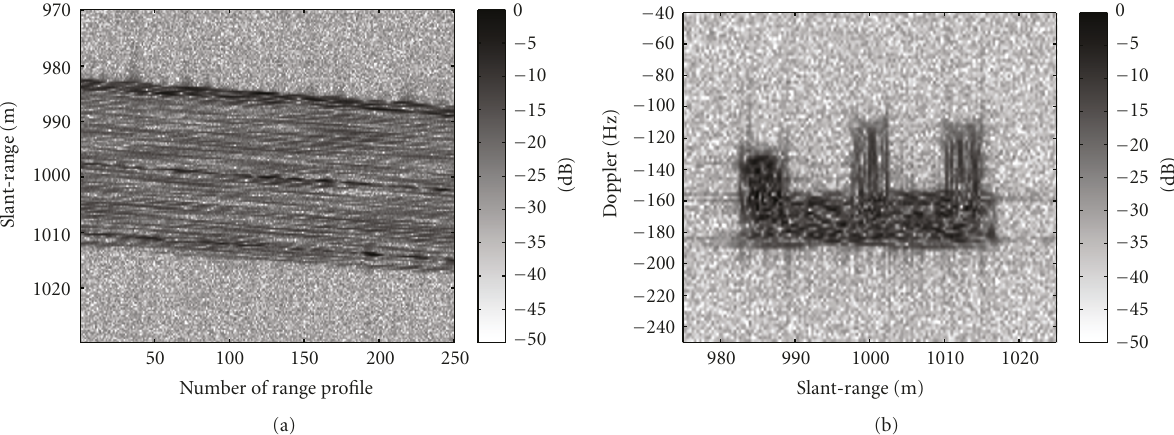
Figure 5: (a) Range profiles and (b) ISAR image for the simulated example with a radial translational velocity of v r = 10 m/s.